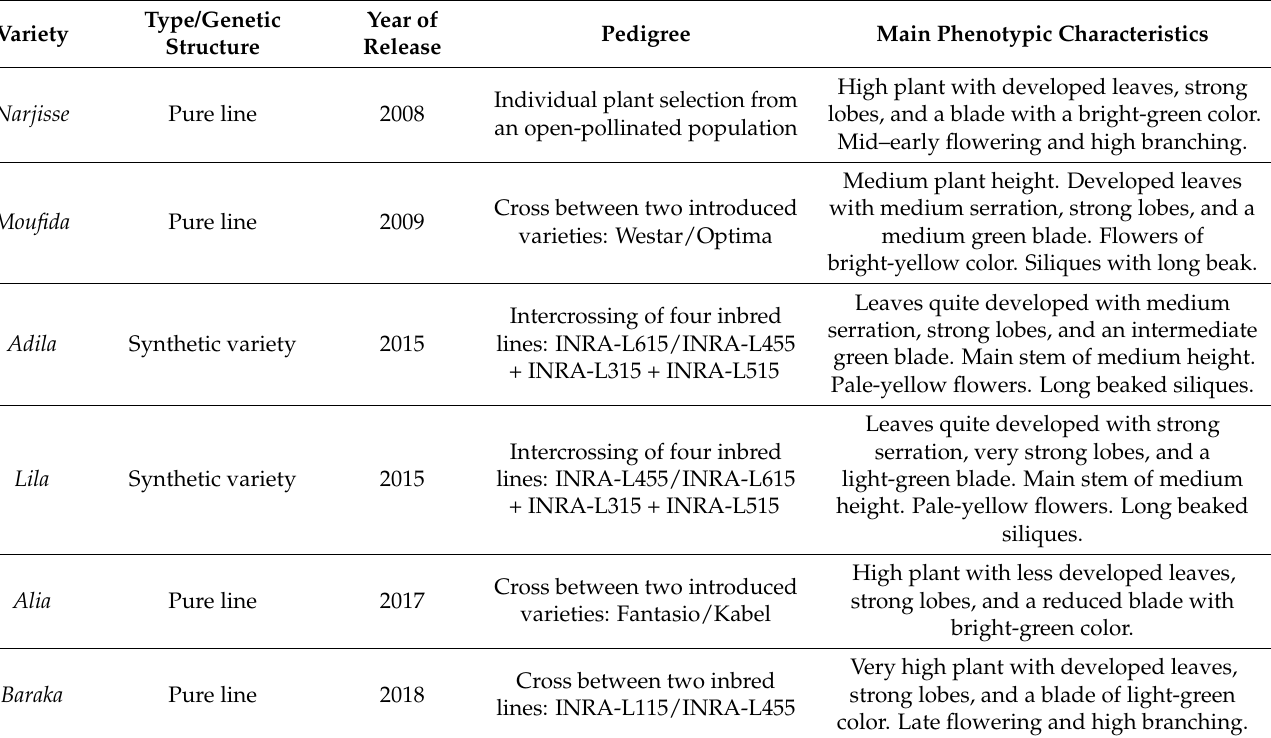
Table 1. Phenotypic description of the six Moroccan rapeseed varieties